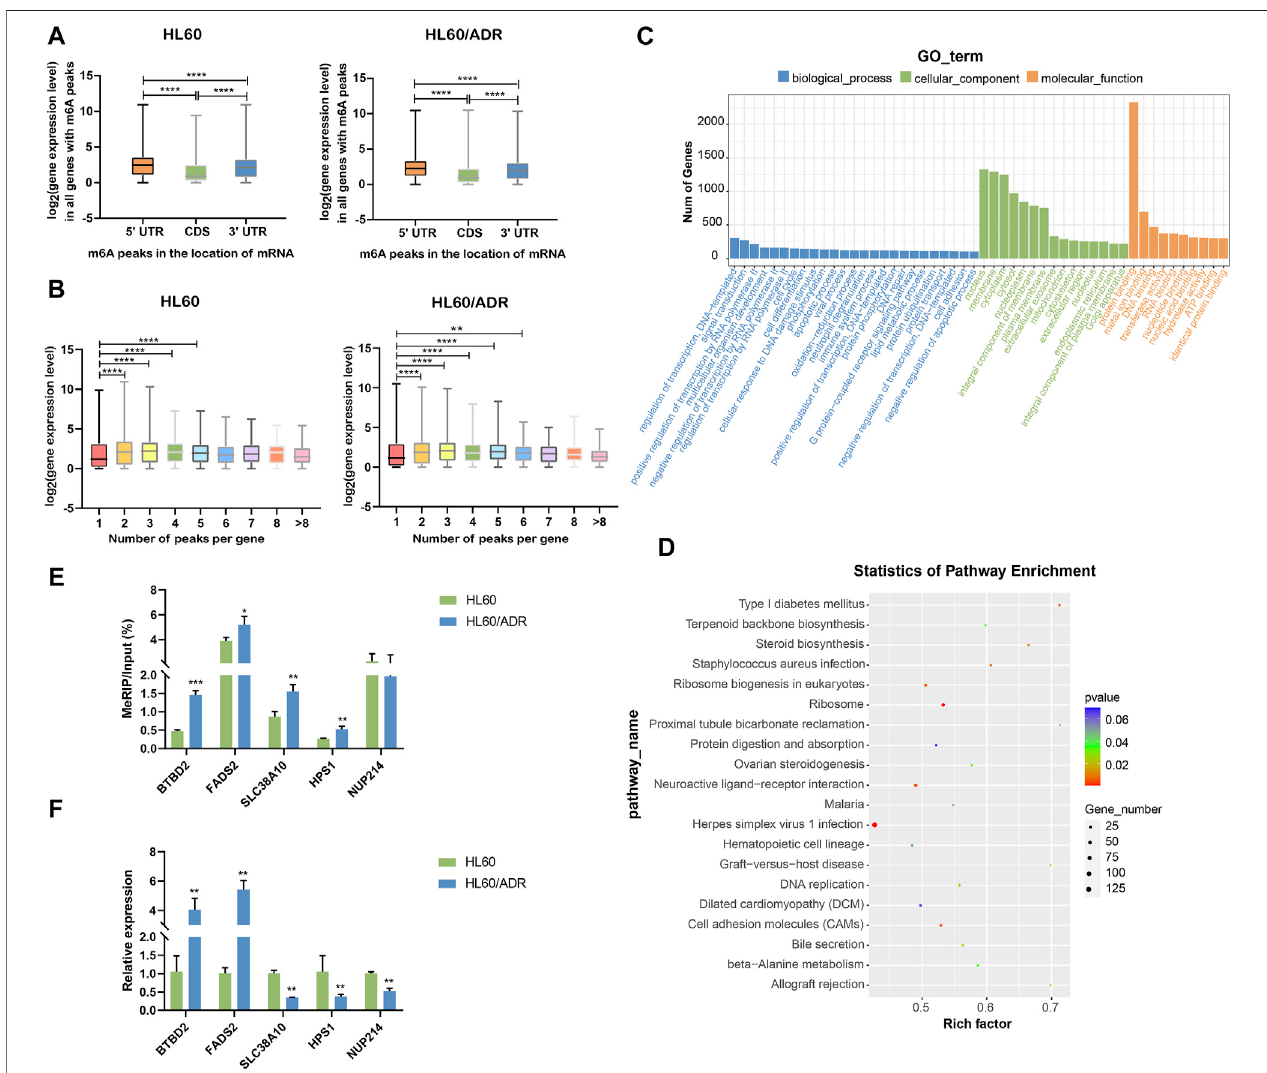
FIGURE4| ConjointanalysisofMeRIP-seqandRNA-seqdata. (A) Analysisoftheexpressionlevelofallgeneswithm 6 Amodi fi cationindifferentlocationsofmRNA. **** p < 0.0001. (B) Analysis of the expression level of genes with a different number of m 6 A peaks. *** p < 0.001, **** p < 0.0001. (C) GO analysis of differentially expressed genes with m 6 A modi fi cation. GO, Gene Ontology. (D) KEGG pathway analysis of differentially expressed genes with m 6 A modi fi cation. Rich factor, signi fi cant gene number/background gene number. KEGG, Kyoto Encyclopedia of Genes and Genomes. (E) Validation of the m 6 A level by m 6 A IP-qPCR in fi ve genes with differential m 6 A modi fi cation. Each group had three biological replicates. (F) Validation of the mRNA level by RT-qPCR in fi ve genes with differential mRNA levels. Each group had three biological replicates.